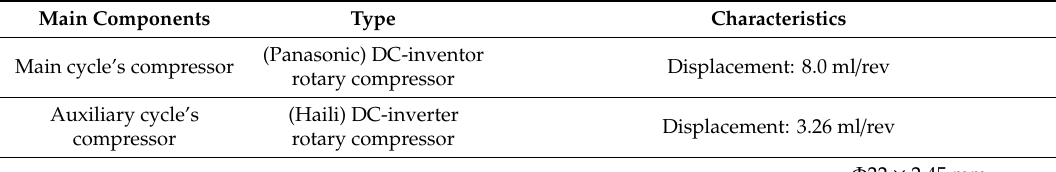
Table 2. The main geometries of the main